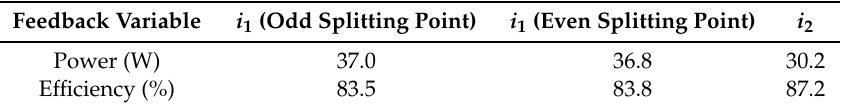
Figure 13. Variation trends of self-oscillating frequency in different feedback mode. ( a ) Feedback variable i 1 , adjust C 1 ; ( b ) feedback variable i 1 , adjust C 2 ; ( c ) feedback variable i 2 , adjust C 1 ; and ( d ) feedback variable i 2 , adjust C 2 . Table 4. Measurement results of power and efficiency.